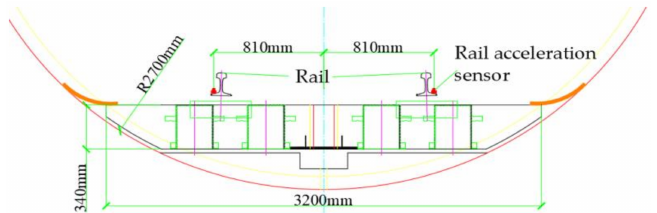
Figure 5. Layout of measuring points for the rail acceleration sensor.